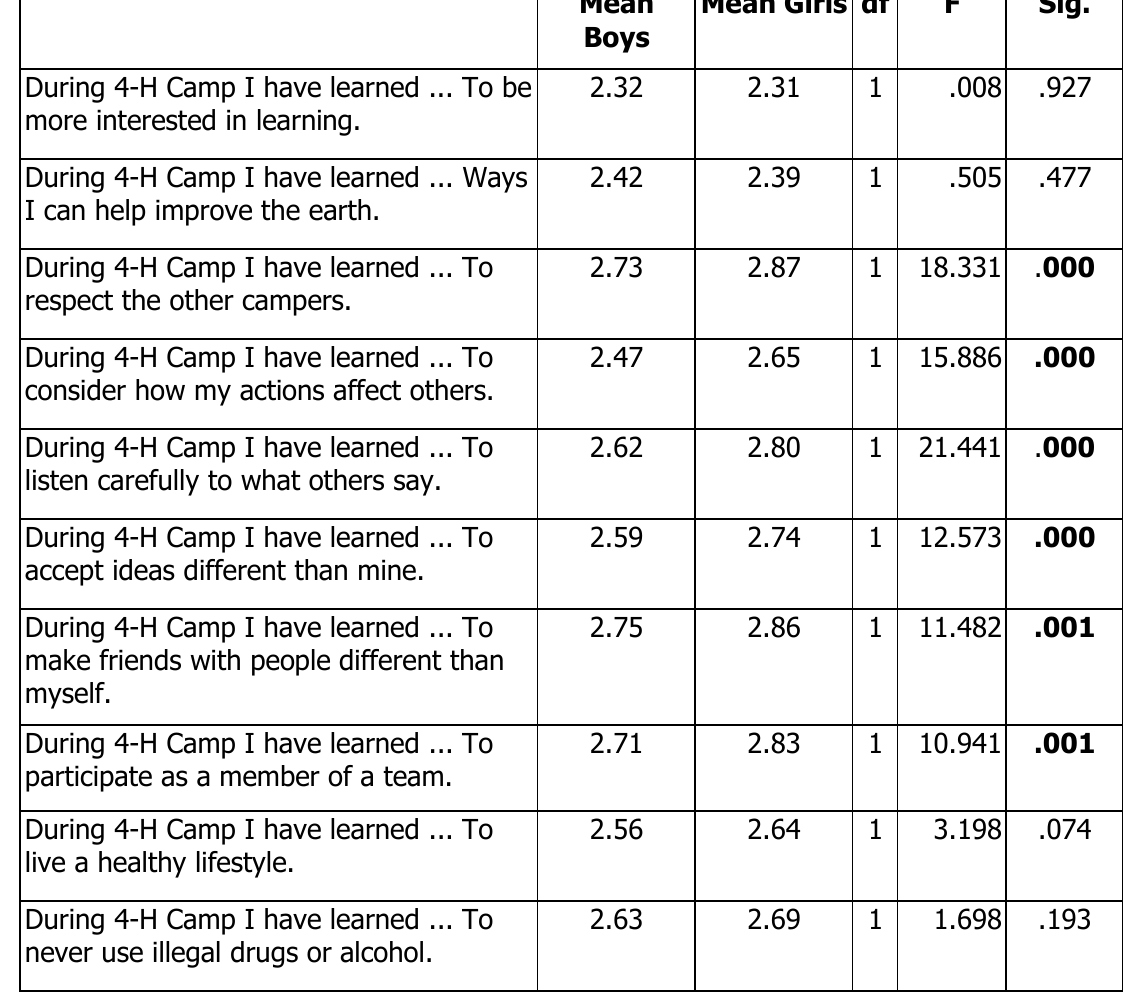
One Way ANOVA Comparing Life Skills Learned by Boys with Life Skills Learned by Girls Mean